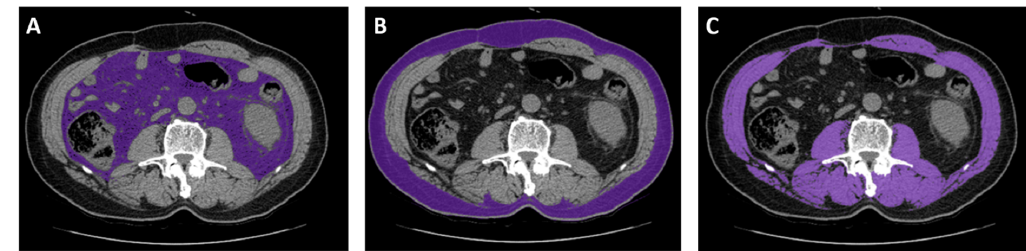
Figure 3. Representative computed tomography measurements of tissues using analysis software. ( A ) Visceral adipose tissue. ( B ) Subcutaneous adipose tissue. ( C ) Skeletal muscle.